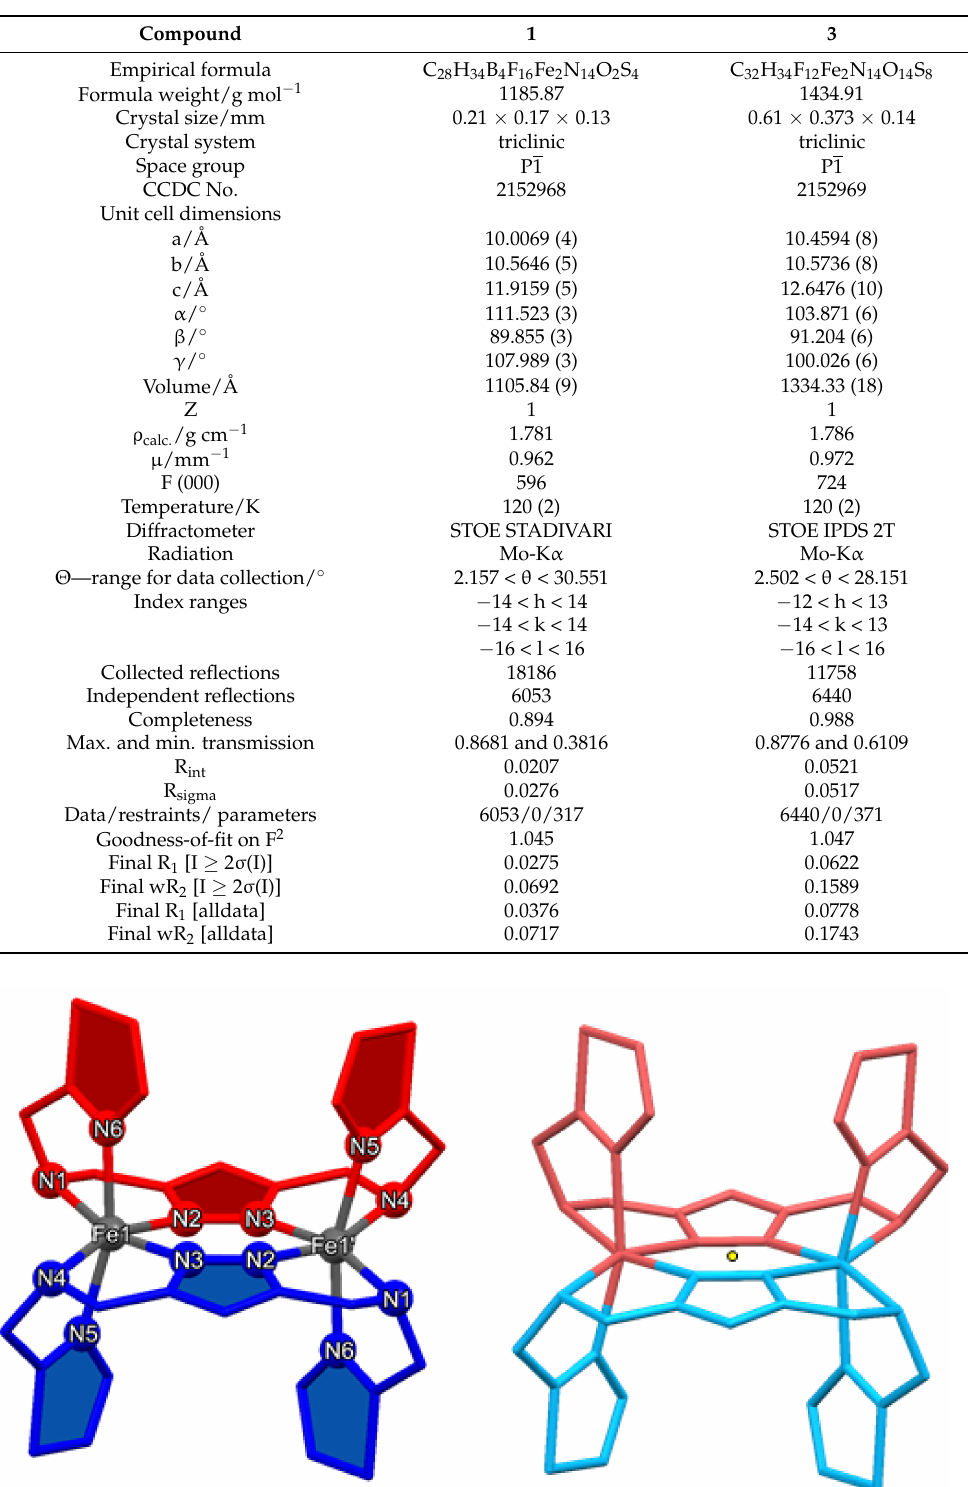
Table 2. Crystallography data for complexes 1 and 3 .